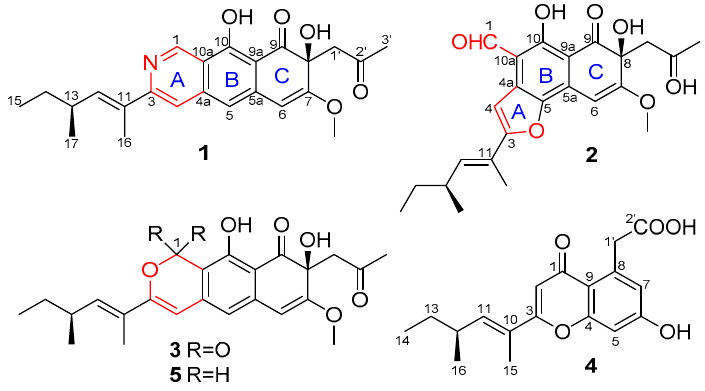
Figure 1. Structures of compounds 1 − 5 .